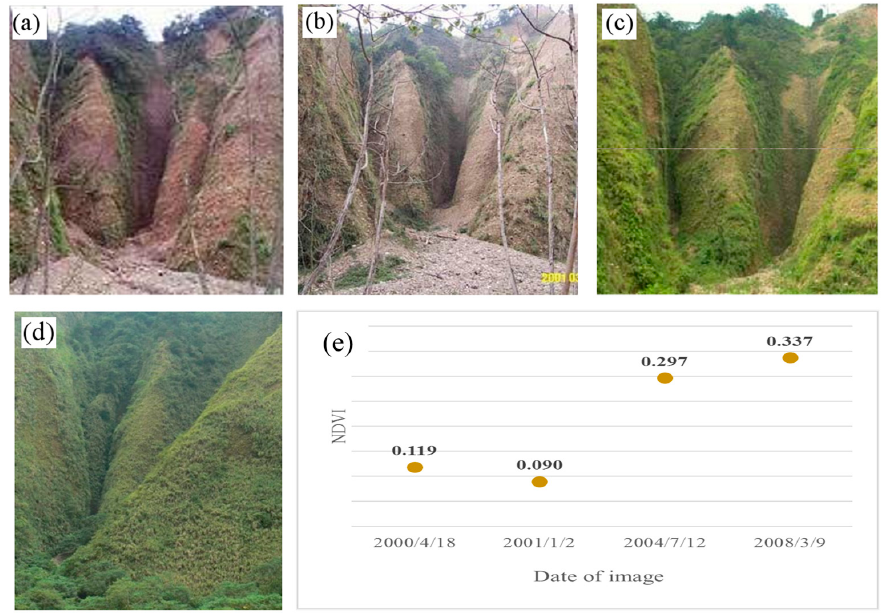
Figure 7. Close-range photographs showing the vegetation recovery of a typical landslide spot at Mt. Jou-Jou shot in ( a ) 2000; ( b ) 2001; ( c ) 2004; ( d ) 2008 and ( e ) corresponding landslide area NDVI value from satellite images.